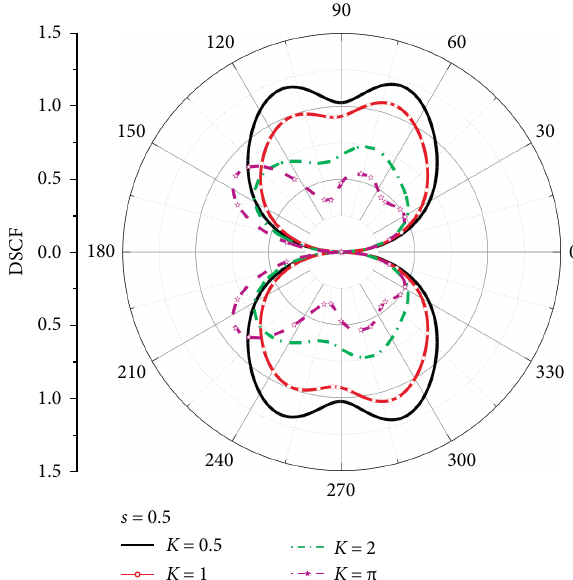
Figure 10: Distributions of DSCF around an ellipse hole with various 5 . 𝐾 for 𝑠 = 0.